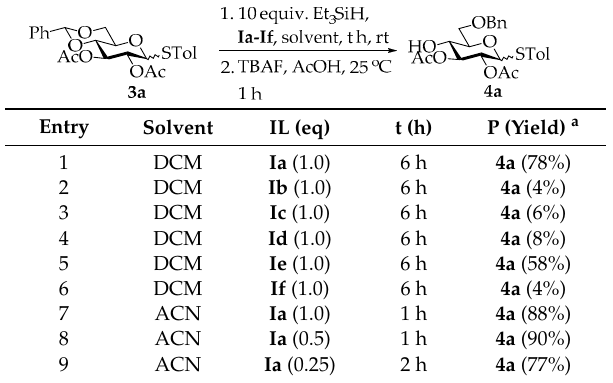
Table 3. Optimized conditions of regioselective O -4 ring-opening reactions.